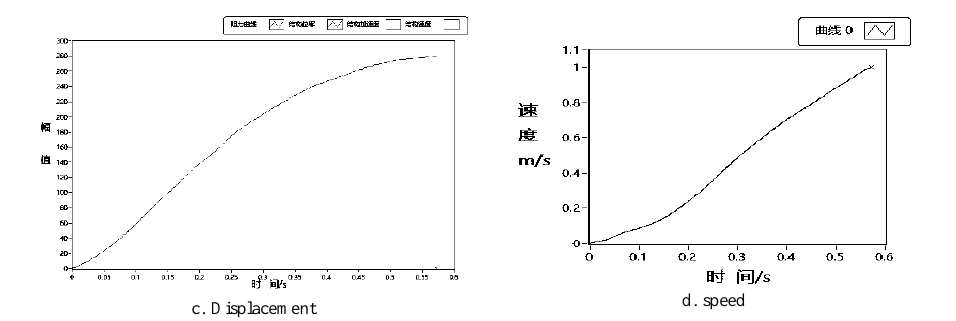
Fig. 8 . JH-14 explosive test measurement data